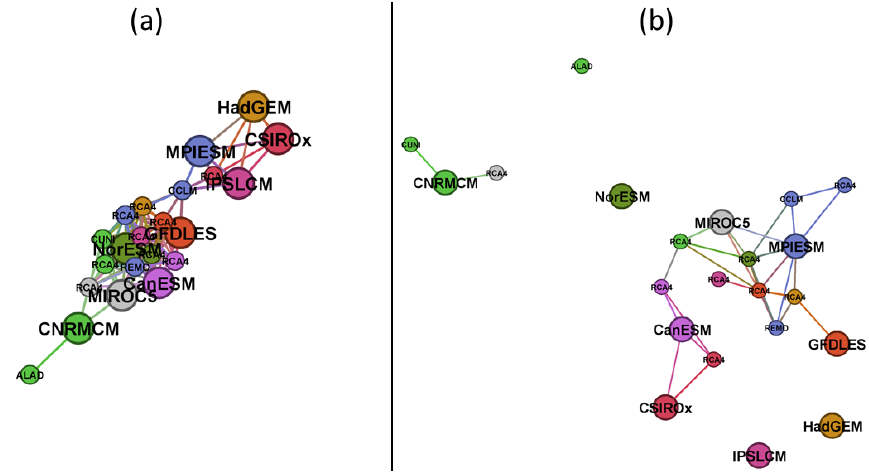
Figure 10. The same as Fig. 9, but for running 30-year mean relative changes in summer (JJA) mean precipitation over eastern European region (underlying similarity matrices in respective panels of Fig.